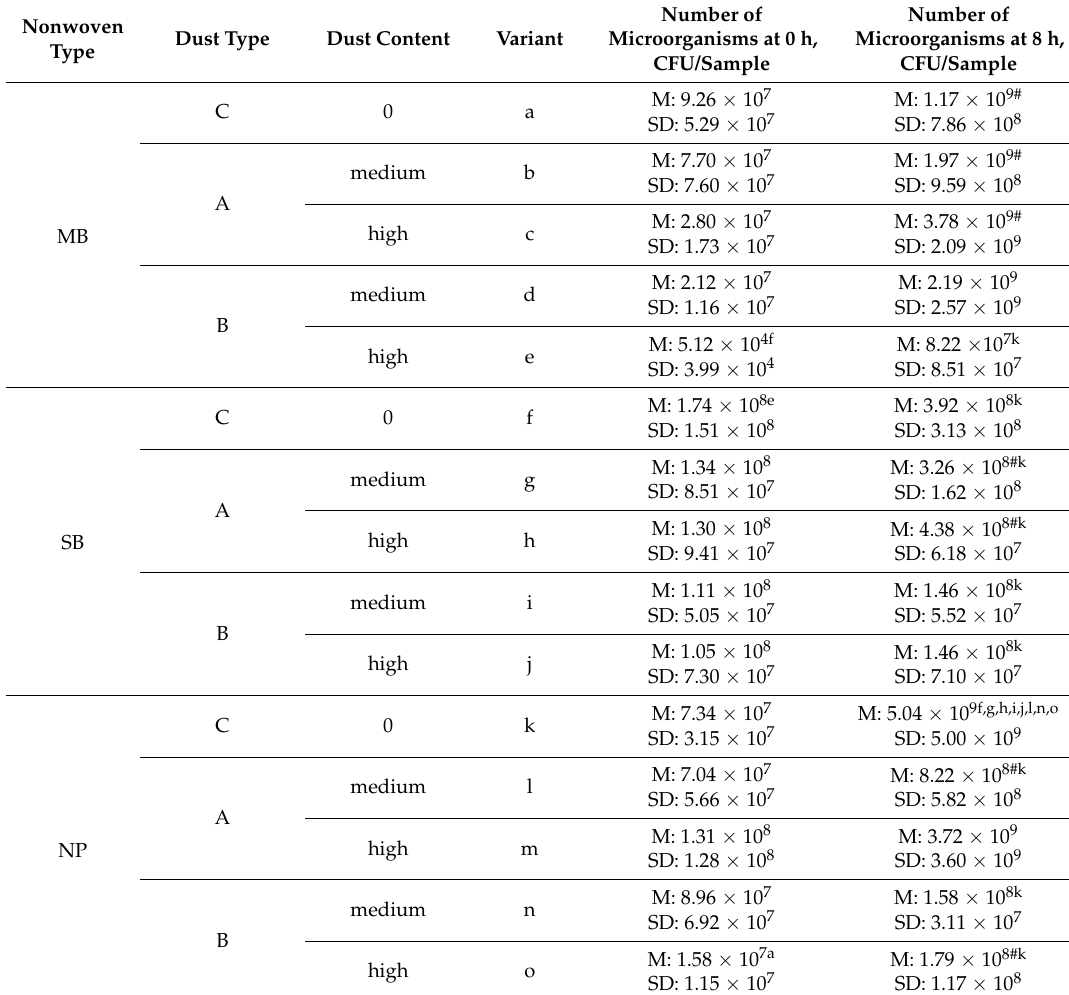
Table 3. Number of Escherichia coli bacteria on the filtering nonwovens depending on dust type and